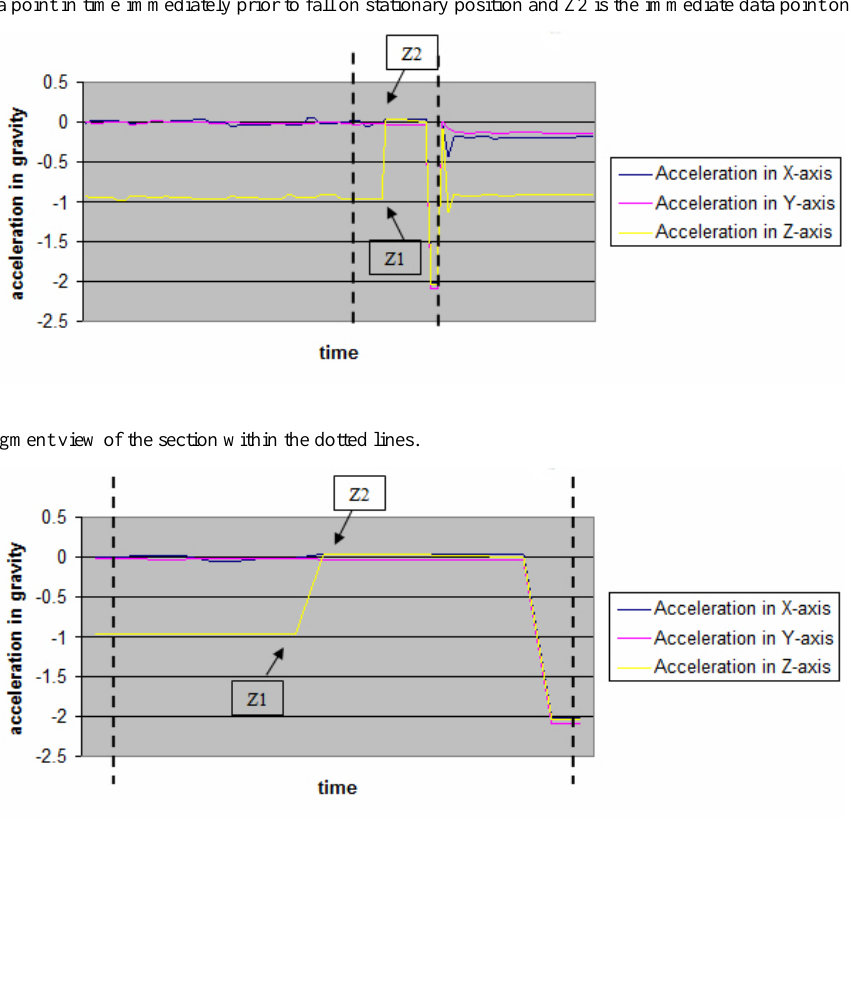
Figure 2. A representative graph generated from the acceleration data (the segment within the dotted line represents the period of time before and after the free fall test; Z1 is data point in time immediately prior to fall on stationary position and Z2 is the immediate data point on falling).